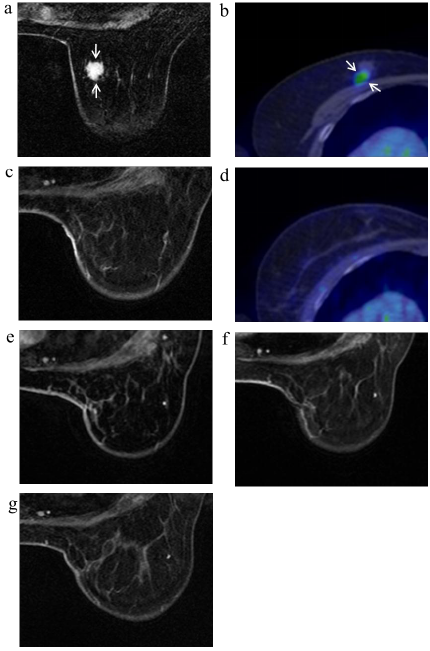
Figure 4. A 63-year-old female (case 8 in Tables 1-3) with right breast cancer (cT1cN0M0). CE breast MRI ( a ) and FDG-PET-CT ( b ) revealed a breast tumor before KORTUC II therapy (arrows), the region of tumor was 13 mm; After KORTUC II, no recurrence was identified on CE breast MRI and FDG-PET-CT (( c ): 10 months; ( d ): 18 months; ( e ): 22 months; ( f ): 34 months; ( g ): 50 months).